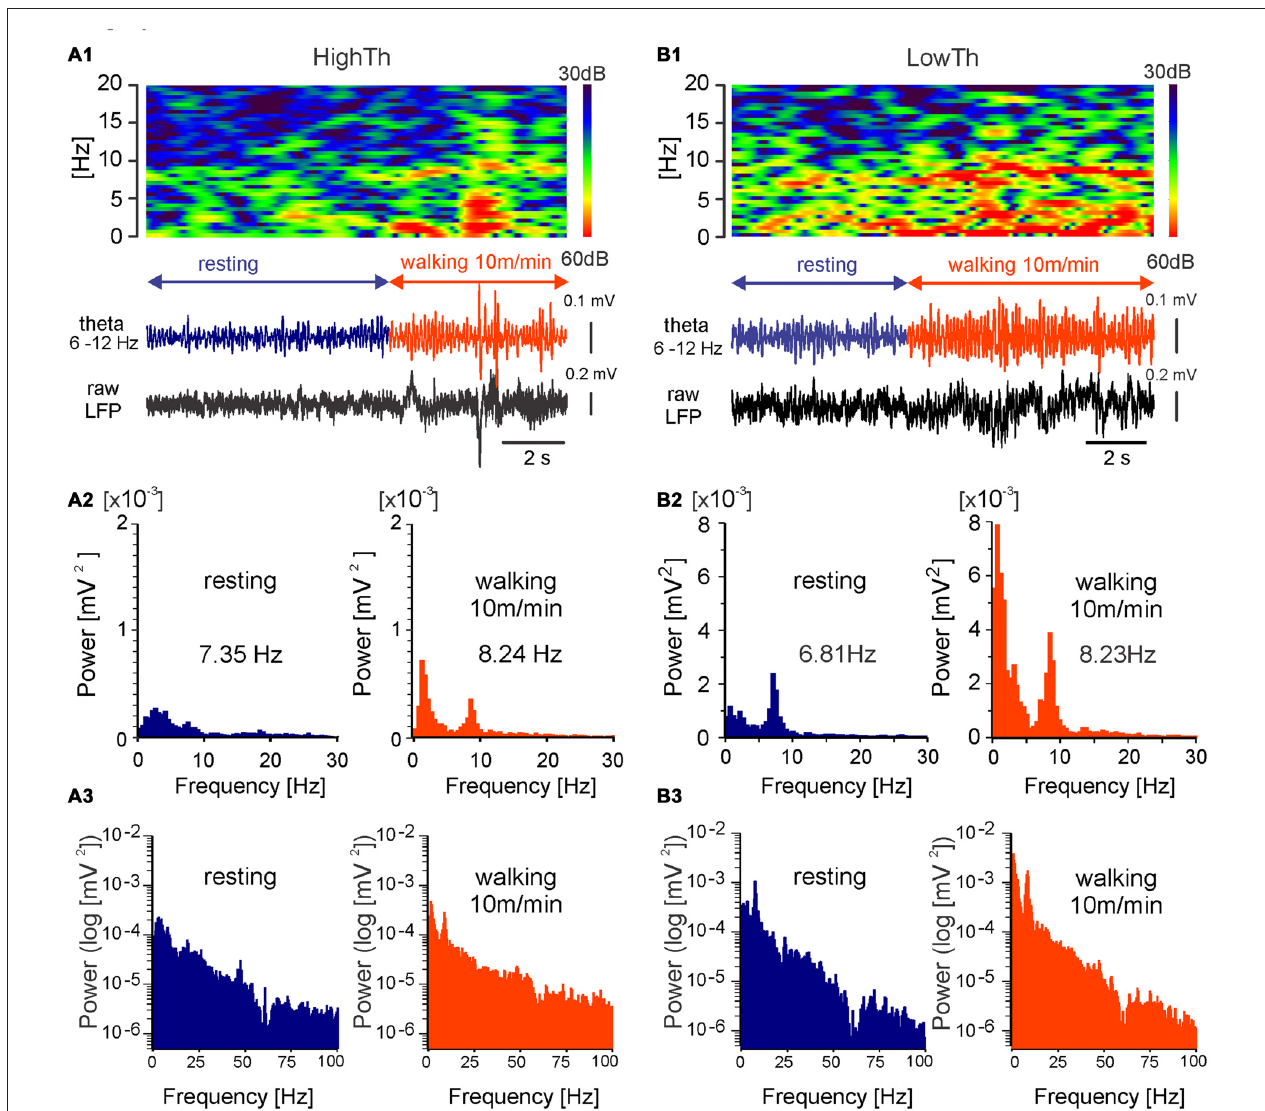
FIGURE 4 | MLR LFP activity during transition from resting to walking in freely moving rat. LFPs recorded during locomotion from LowTh sites show a larger increase in the power of delta and theta bands in comparison to the HighTh sites. Top in (A1) frequency spectrogram (frequencies between 0 Hz and 20 Hz) plotted vs. time of LFP recorded from a HighTh site; bottom in (A1) LFP, filtered 6–12 Hz and raw, recorded from a HighTh site; (A2) histograms of power spectra in linear scale for corresponding data segments; (A3) histograms of power spectra in logarithmic scale for corresponding data segments; Top in (B1) frequency spectrogram (frequencies between 0 Hz and 20 Hz) plotted vs. time; bottom in (B1) LFP, filtered 6–12 Hz and raw, recorded from LowTh site; (B2) histograms of power spectra for corresponding data segments. (B3) histograms of power spectra in logarithmic scale for corresponding data